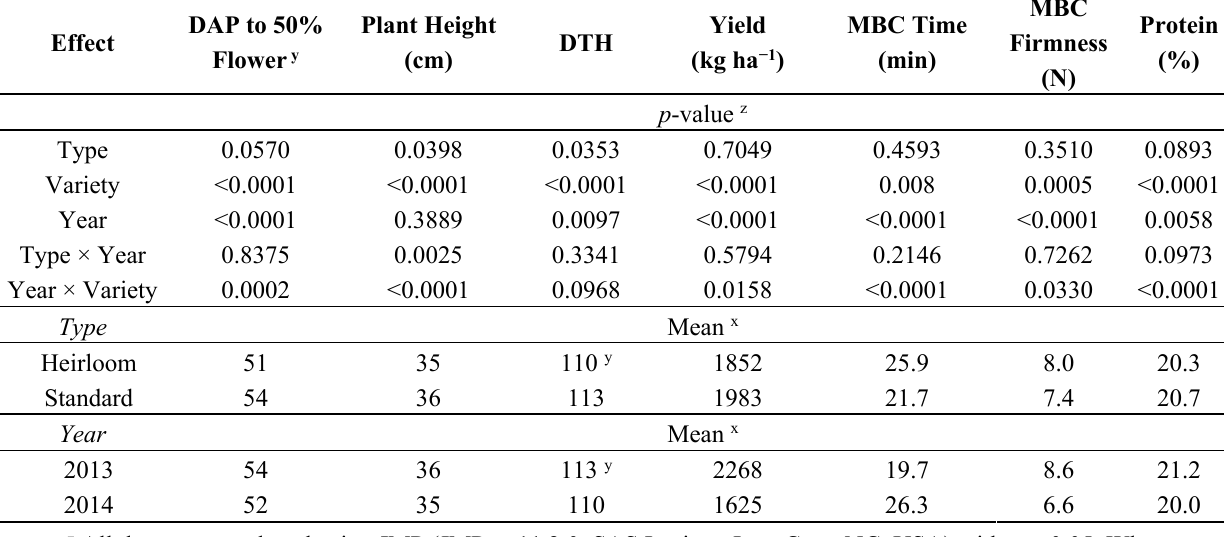
Table 2. ANOVA tests and means for days after planting (DAP) to 50% flower, plant height (cm) at 50% flowering, days to harvest (DTH), yield (kg·ha −1 ), cooking time with a Mattson bean cooker (MBC), bean firmness after cooking with MBC and protein content (%) of